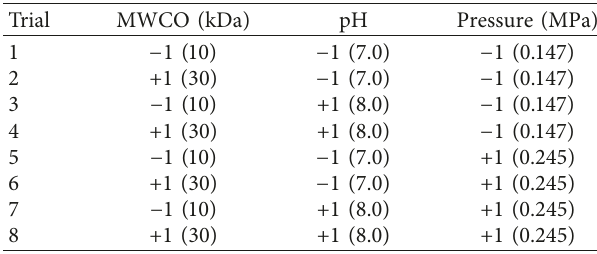
Table 1: Experimental design 2 3 in coded levels (real